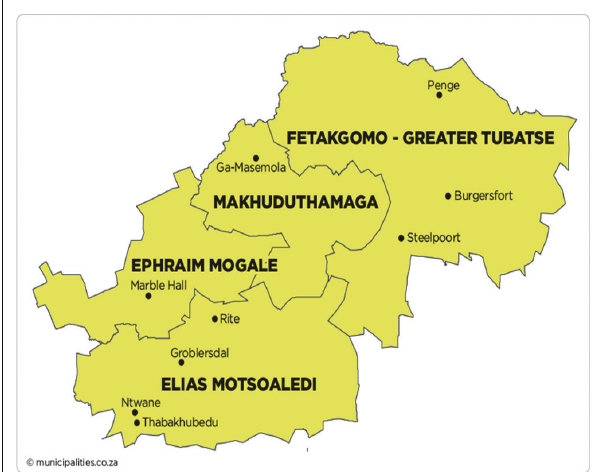
FIGURE 1: Sekhukhune map.